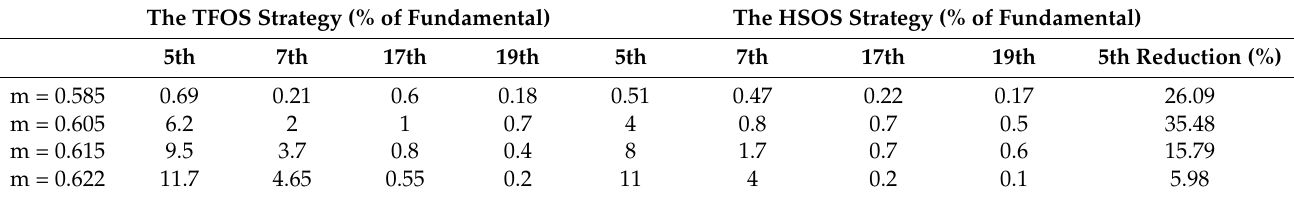
Table 3. Voltage THD Z